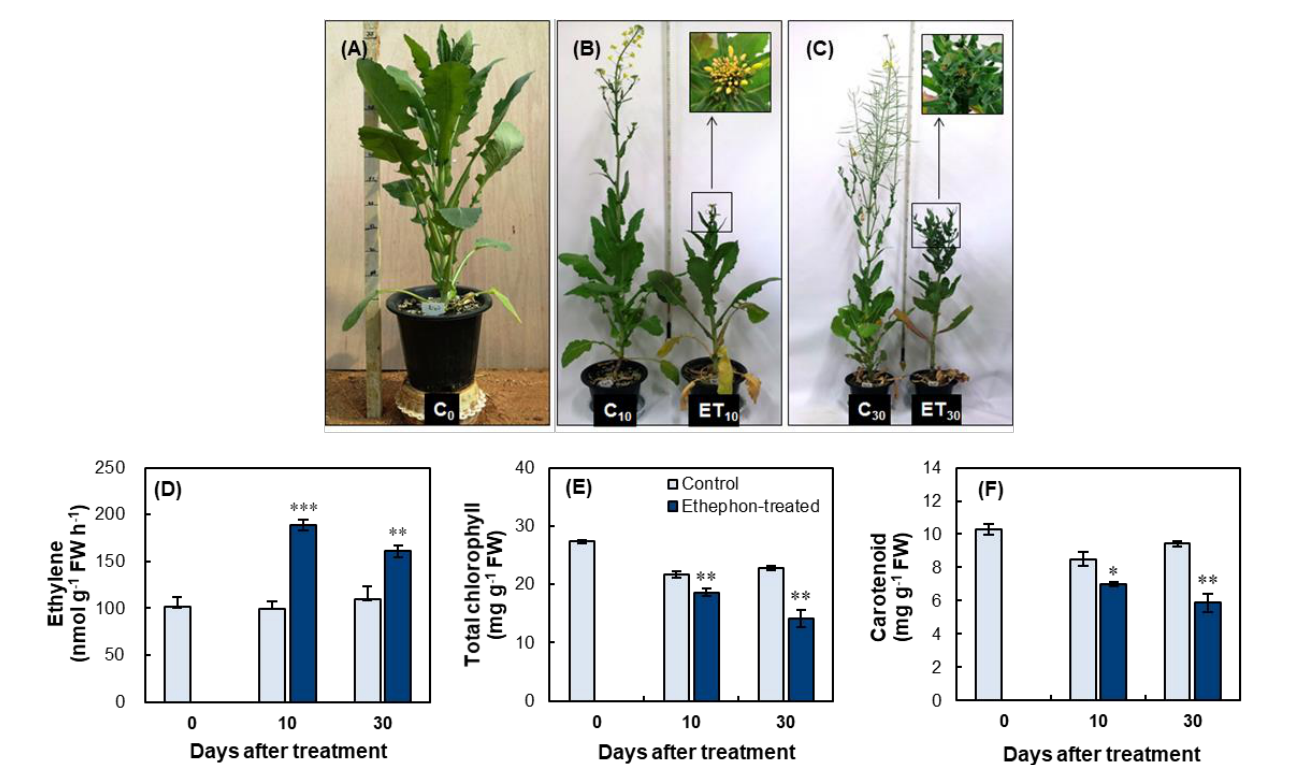
Figure 3. Long – term effects of 100 ppm ethephon application on plant morphology, ethylene content, and leaf senescence. ( A – C ) Plant morphology changes before the ethephon application (day 0, ( A )), at the end of ethephon application for 10 days (day 10, ( B )), and an additional 20 days after the treatment (day 30, ( C )). ( D ) Ethylene, ( E ) total chlorophyll, and ( F ) carotenoid contents in mature leaves of the control and ethephon-treated plants. C 0 , C 10 , and C 30 indicate the control plants at day 0, day 10, and day 30, respectively, whereas ET 10 and ET 30 indicate the ethephon-treated plants at day 10 and day 30, respectively. Data are presented as mean ± SE ( n = 3). Significant differences between treatments are represented by * p < 0.05; ** p < 0.01; *** p < 0.001. Table 1. Plant height, stem width, and biomass of different tissues for the control and ethephon-treated plants before the ethephon application (day 0), at the end of ethephon application for 10 days (day 10), and an additional 20 days after the treatment (day 30). Data are presented as mean ± SE ( n = 3).